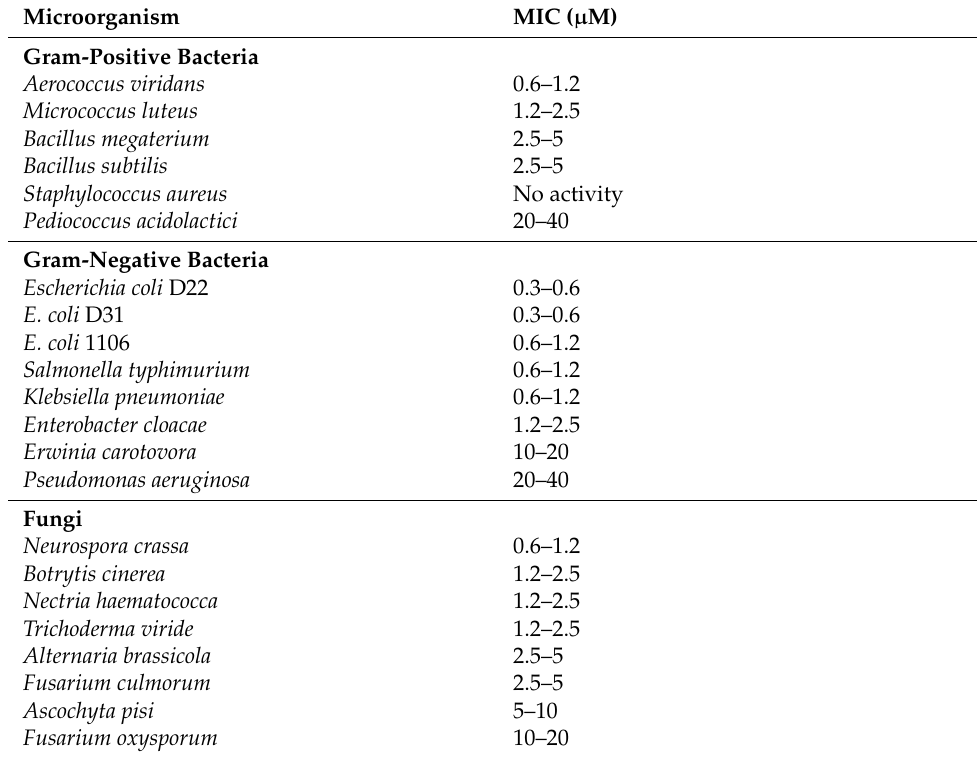
Figure 1. Amino acid sequences of thanatin and brevinin-1. The central Thr residue in the disulfide loop of thanatin is highlighted in green. Cys residues are indicated in blue. Table 1. Antimicrobial activity of thanatin against bacteria and fungi [24].